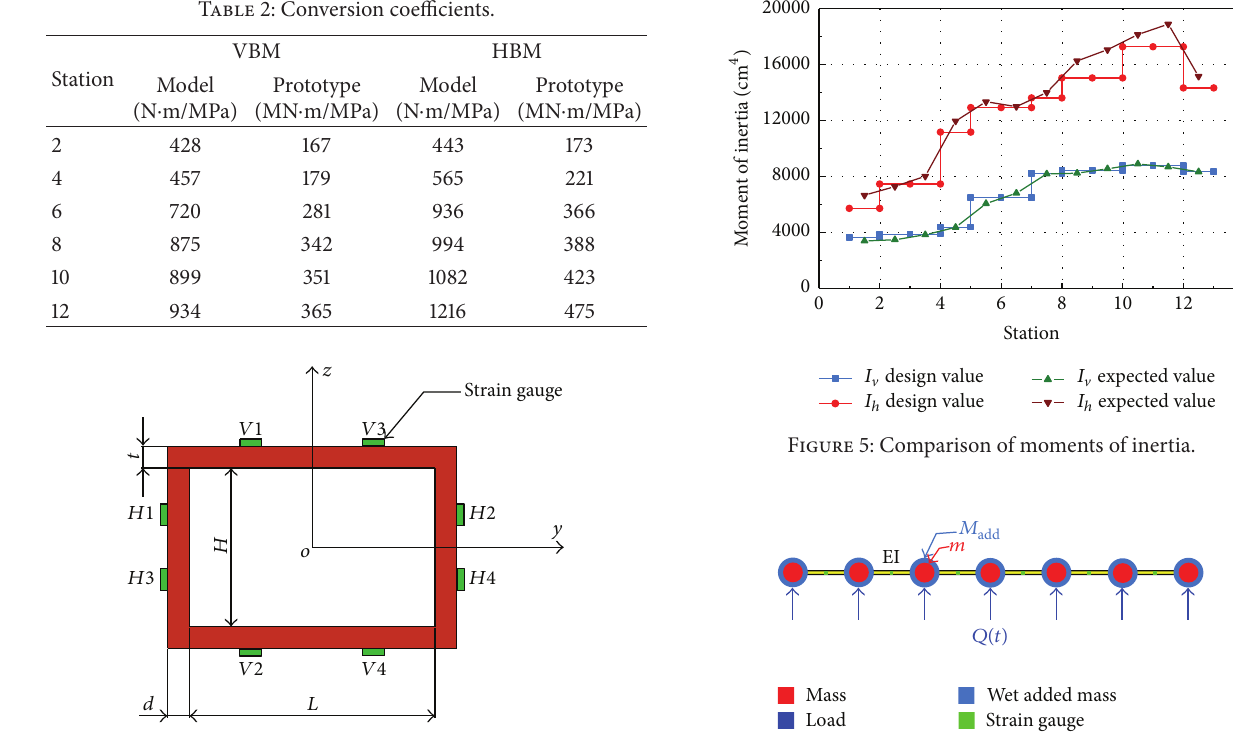
Figure 4: Cross section of backbone beam.